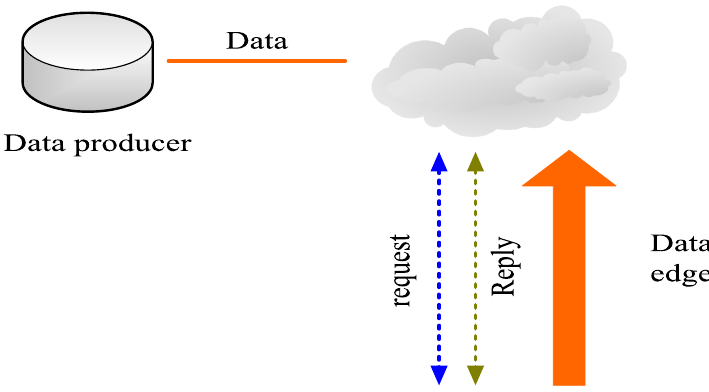
Fig. 6 Edge calculation model diagram